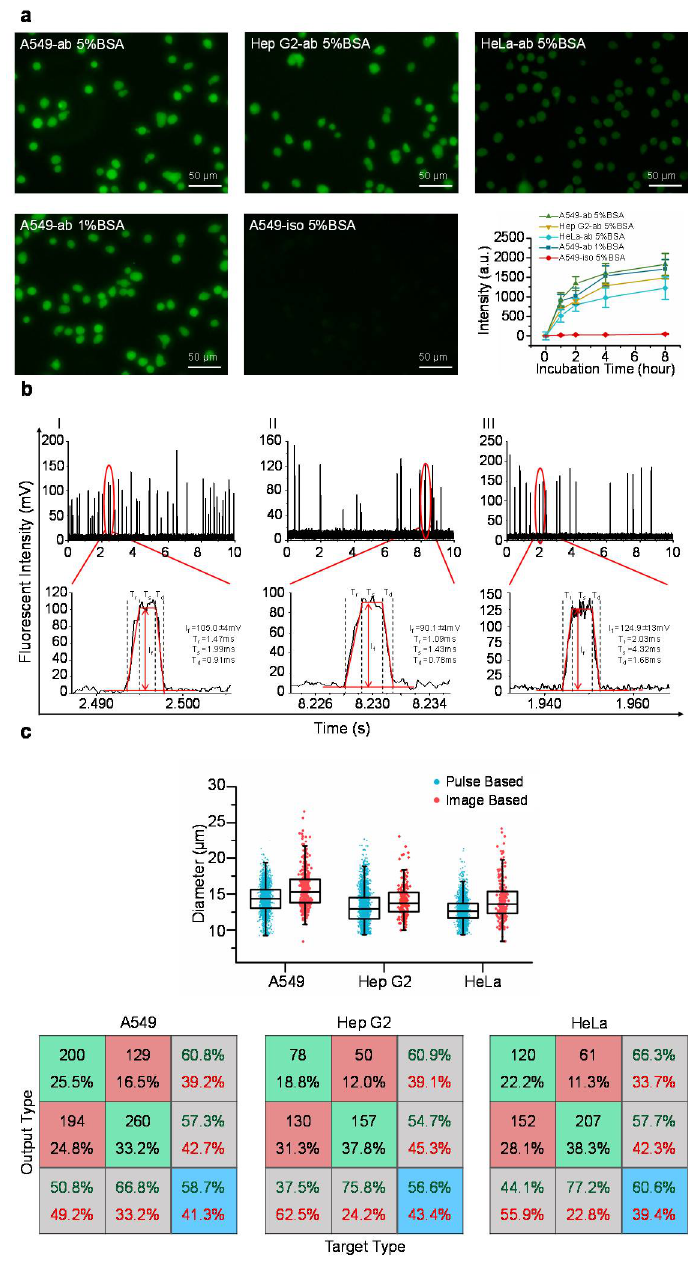
Figure 2. ( a ) Fluorescent pictures of stained A549, Hep G2, and HeLa cells where the intensities of single cells stained with fluorescence labelled anti-β-actin antibodies or isotype controls were quantified as a function of time under two concentrations of bovine serum albumin (1% vs. 5%) for blocking. These results validated the process of intracellular staining where (1) all the exposed proteins are taken by the fluorescence labelled antibodies and (2) non-specific sites within cells are properly blocked; ( b ) Fluorescent pulses of travelling A549 (I), Hep G2 (II), and HeLa (III) cells can be effectively divided into rising domains, stable domains and declining domains based on curve fitting; ( c ) The scatter plots of diameters of cells based on the processing of fluorescent pulses vs. images of microscopy where neural network based pattern recognition produced successful classification rates of 58.7% of A549 cells, 56.6% of Hep G2 cells and 60.6% of HeLa cells. These results indicate that comparable cell diameters were obtained based on curve fitting of fluorescent pulses and processing of microscopic images, validating the processing of fluorescent pulses.